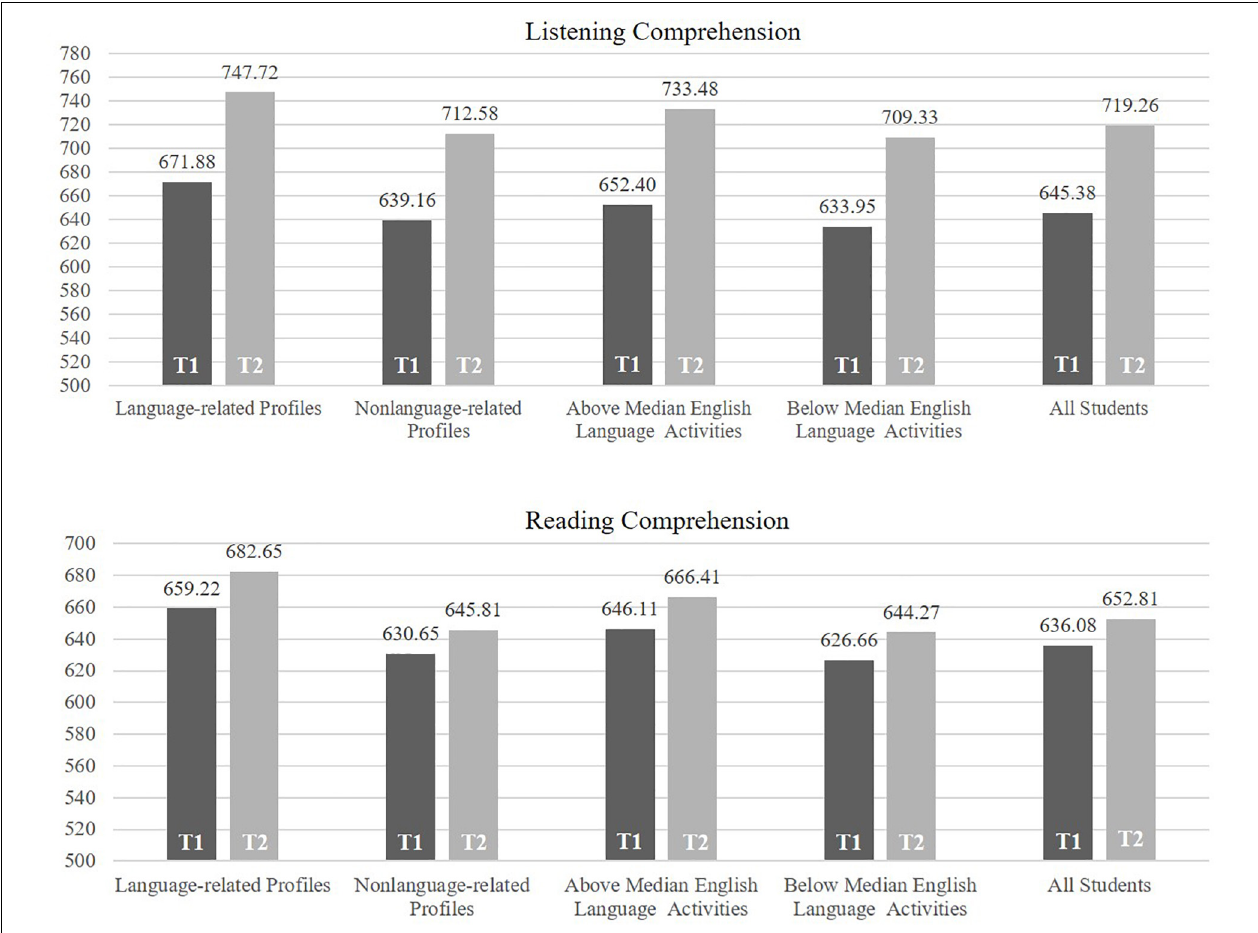
FIGURE 1 | Listening comprehension and reading comprehension for students in the language-related and the non-language-related study profiles, for students with above and below median English language-related extracurricular activities, and for all students at two measurement occasions (T1 = Measurement Occasion 1, T2 = Measurement Occasion